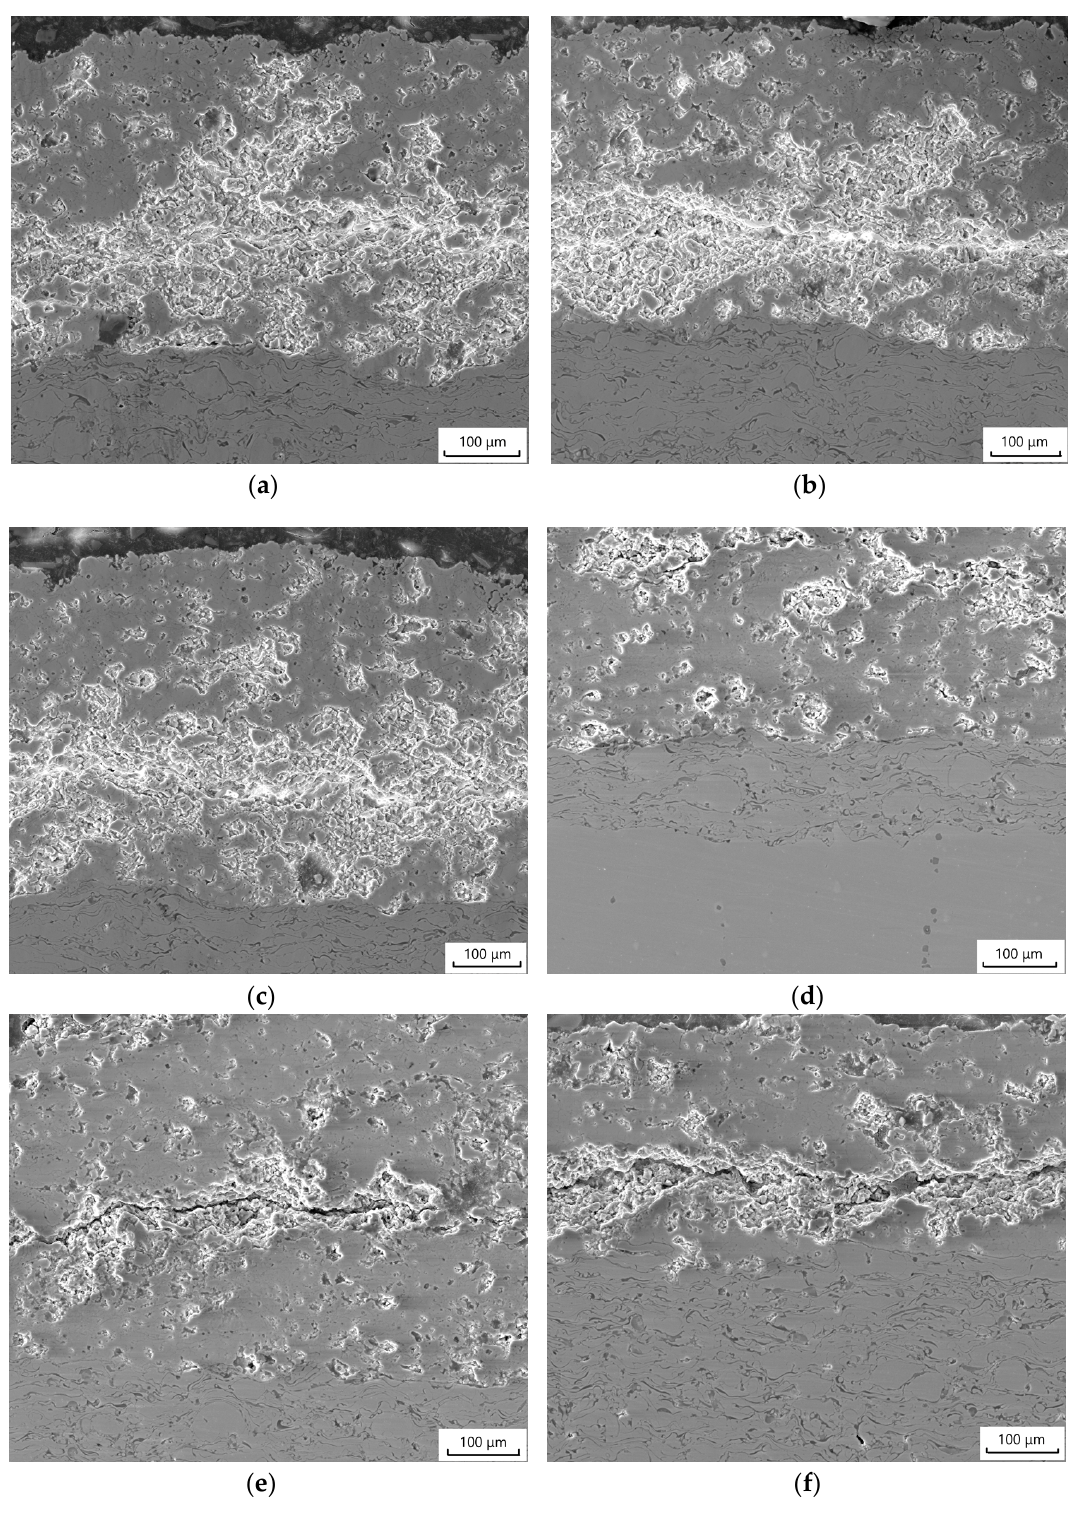
Figure 13. The cross-section morphology of the top coats in TBCs with add 15% pore former at 1100 °C for different serving times: ( a ) 1 day; ( b ) 10 days; ( c ) 20 days; ( d ) 30 days; ( e ) 60 days; ( f ) 90 days.